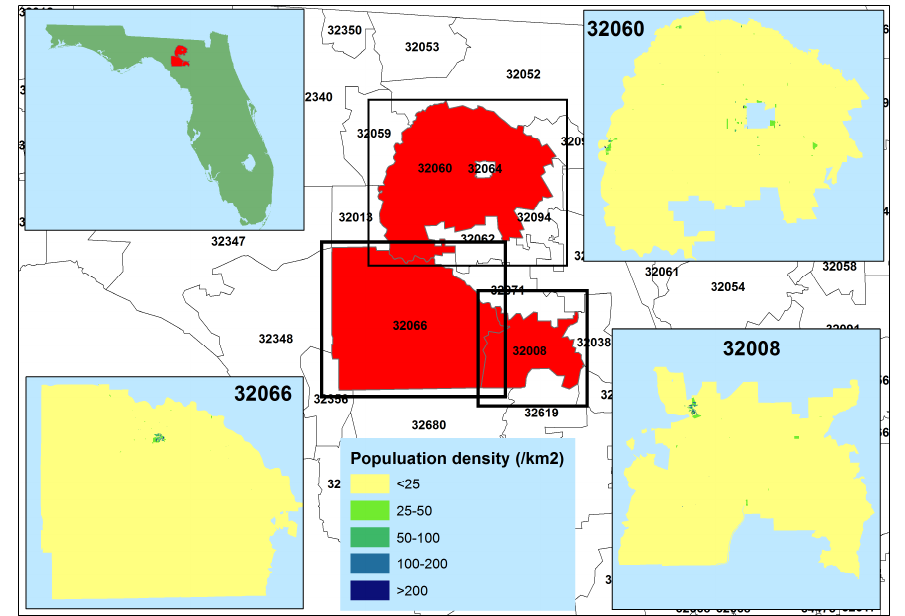
Figure A1. The central map shows the spatial extent of three surveyed communities (ZIP code areas). The upper left map indicates the geographic location of surveyed areas in Florida. Maps in the other three corners depict the density of general population within three communities. Table A1. Demographic summary of participants a .